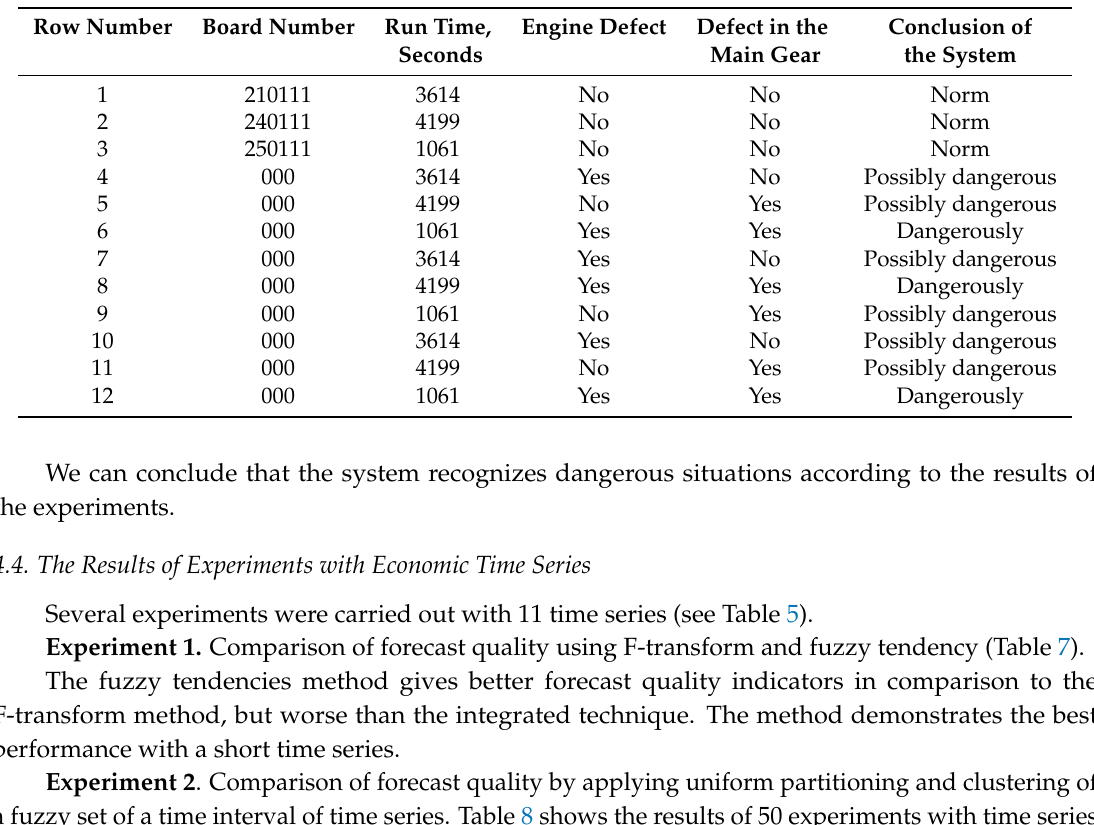
Table 6. The result of the experiment with technical